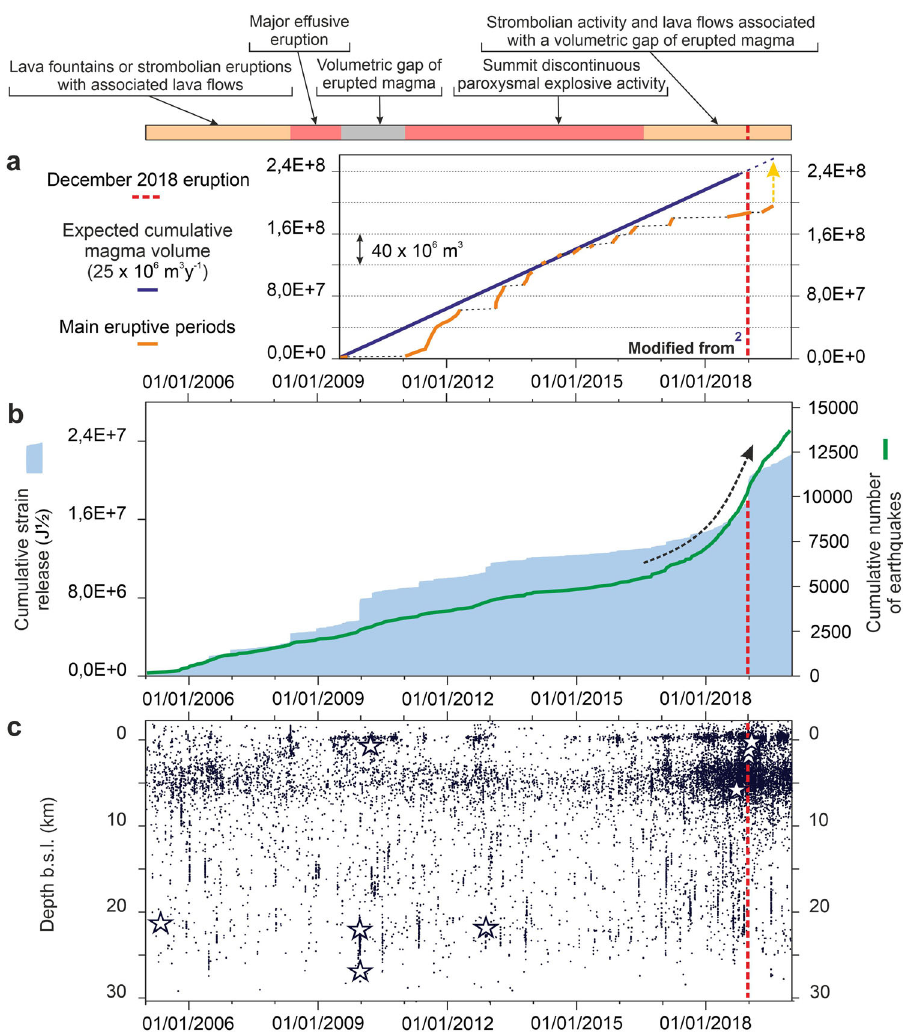
Fig. 2 Etna volcano activity from 2005 to 2019. a Expected cumulative magma volume, according to the steady-state balancing law proposed by ref. 2 (blue line), and cumulative volumes of magma discharged during the main eruptive periods of Etna from 2009 to 2019 (orange line); the yellow-dashed arrow indicates the gap in erupted magma volume at the end 2019. b Cumulative number of earthquakes occurring in the Etna area between 2005 and 2019 (green line) and related cumulative seismic strain release; the black-dashed arrow highlights the major change in seismicity pattern observed after mid-2016. c Depth versus time distribution of the seismic events throughout the whole time span; stars indicate earthquakes with M L > 4. In all the panels, the vertical red-dashed line marks the December 2018 major Etna unrest